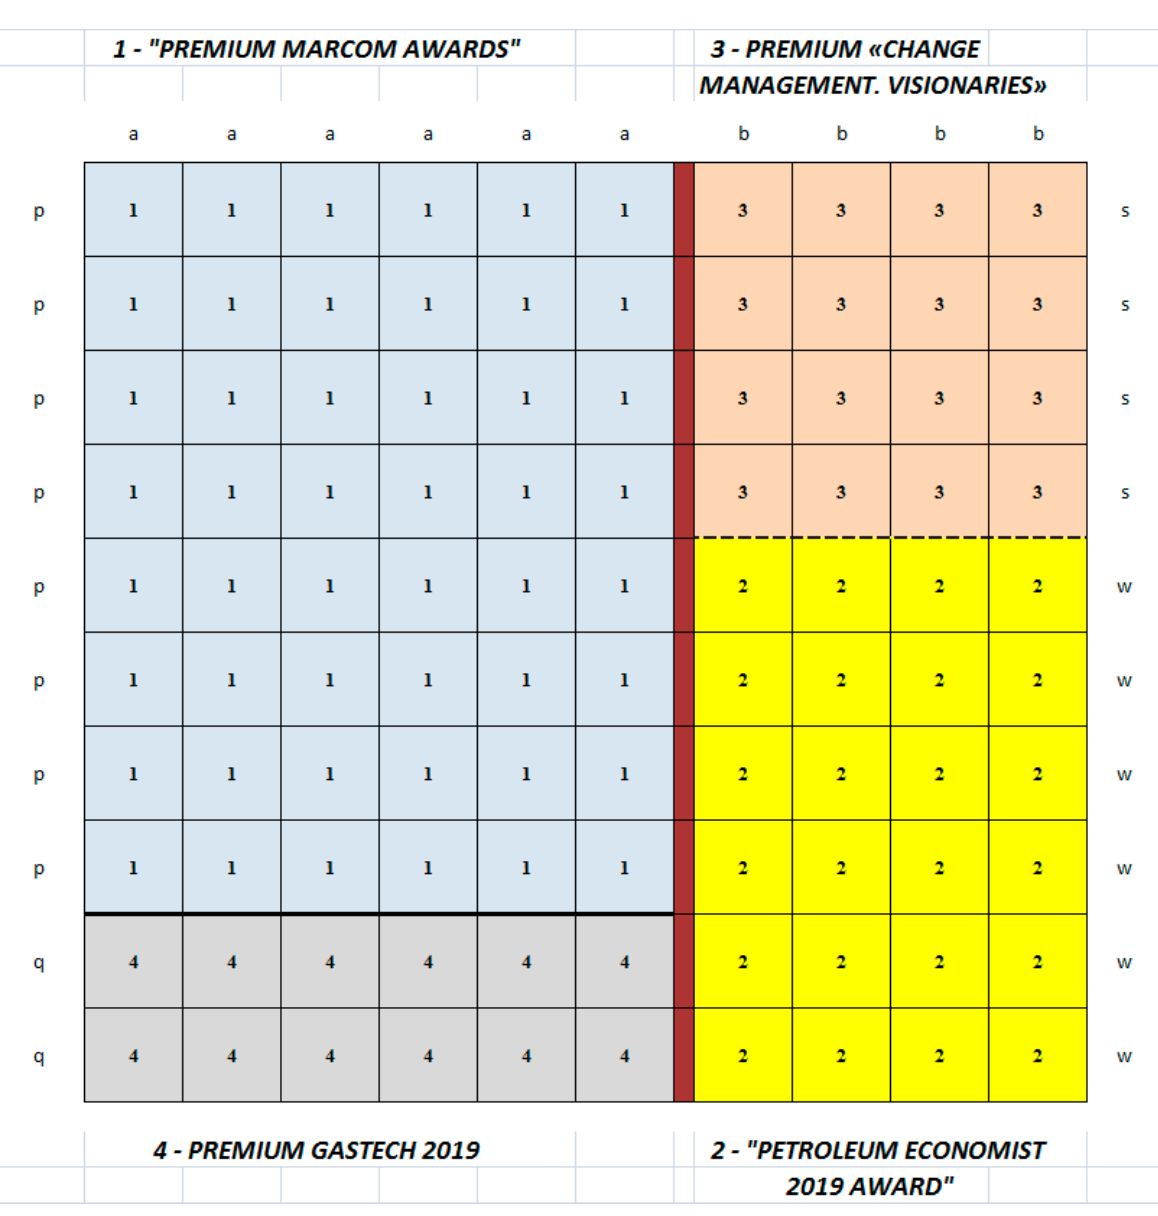
Figure 3. Screen zoning layout for images 1, 2, 3, and 4 (descending rank).